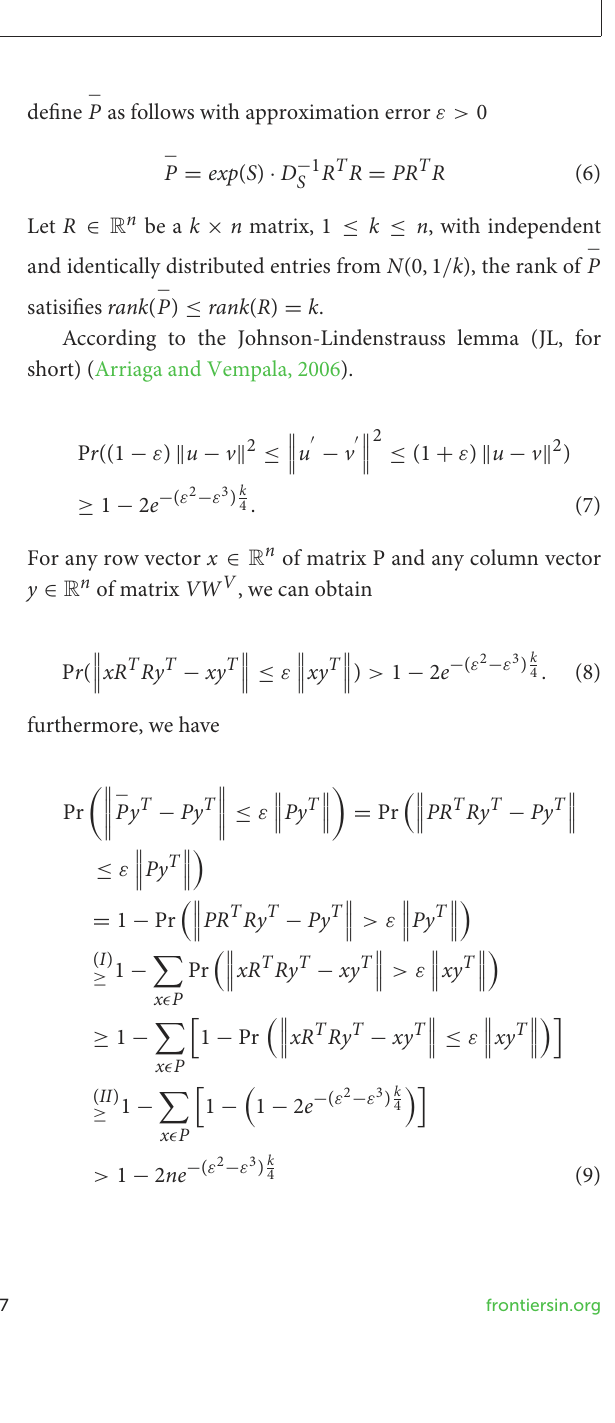
FIGURE3 Linear mapping layers.